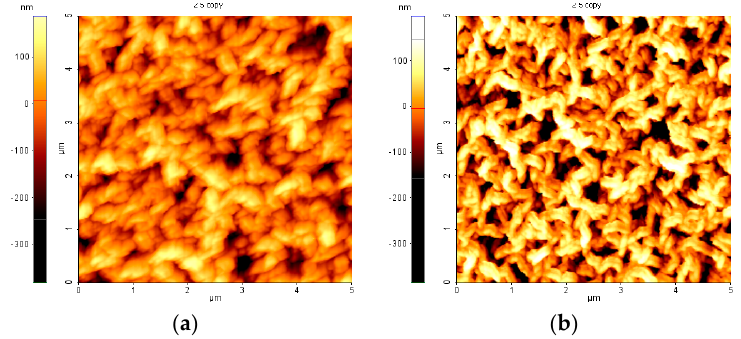
Figure 11. The topography of CNW after SF 6 plasma treatment using ( a ) 2 sccm; and ( b ) 36 sccm.